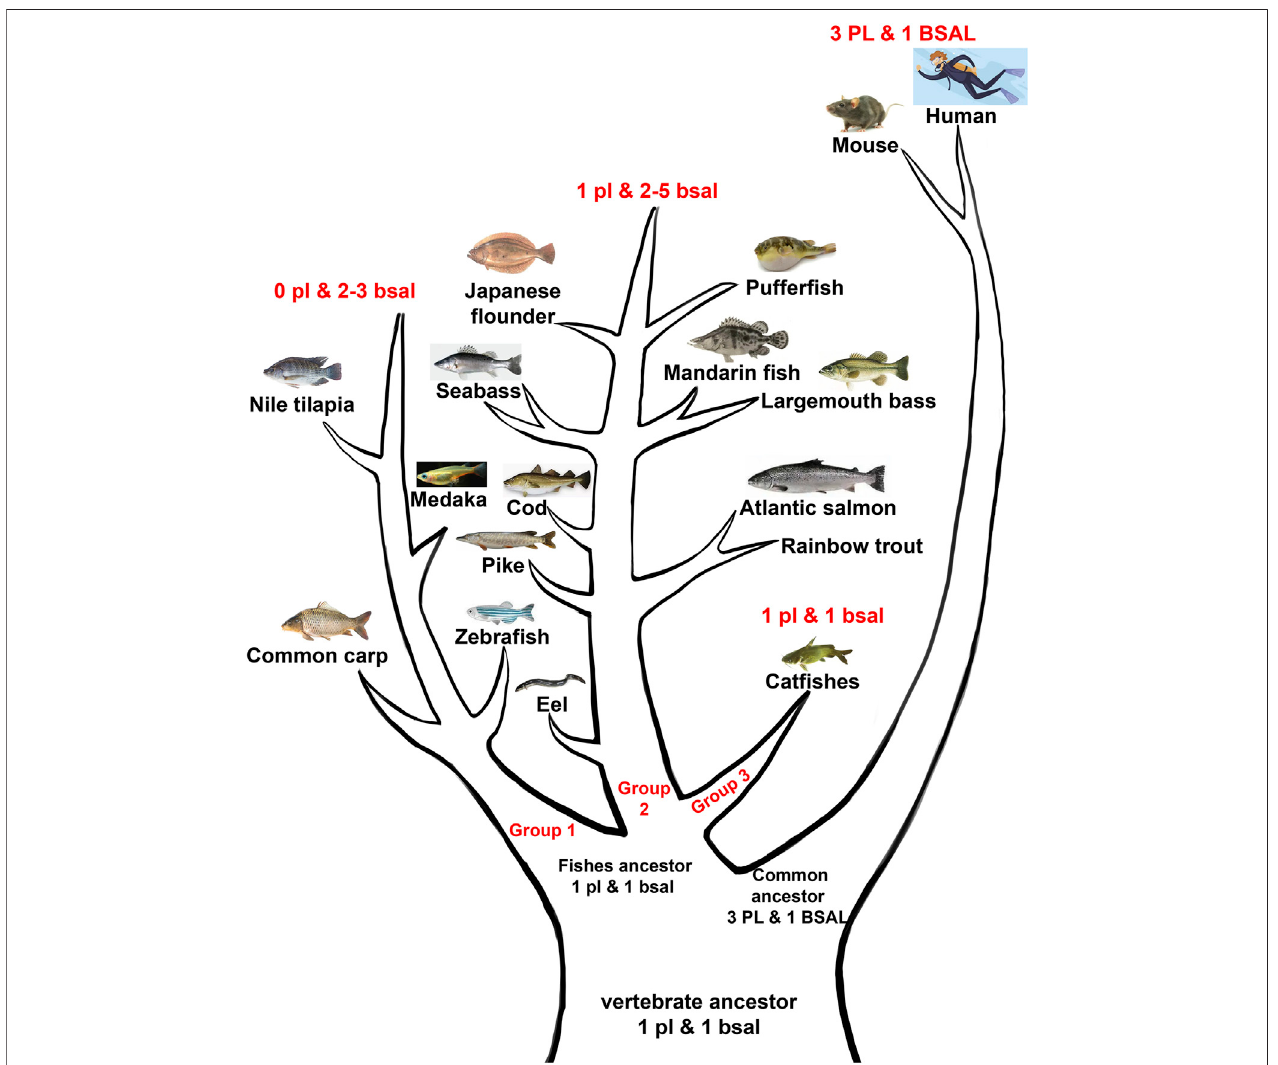
FIGURE9| Abridgedgeneralviewofdigestivelipasesduringtheevolutionamongmammalsand fi shes.Thevertebrateancestormighthaveone pl geneand1 bsal gene,the fi sh ancestor retained the one pl gene and one bsal gene, then fi sh ancestor divided intothree groups, the fi rstgroup lost the pl gene but had twoto three bsal gene copies (group 1), the second group had one pl gene and had two to fi ve bsal gene copies (group 2), the third group retained the one pl, and 1 bsal (group 3). The common ancestor of mammals obtained other PL gene copies but retained one BSAL gene.